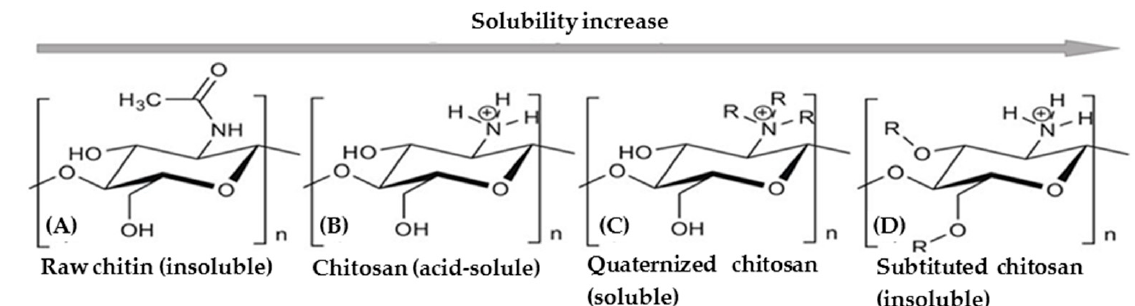
Figure 6. Depiction of chitin and chitosan by functionalization of the chemical structure and the solubility of the biopolymer. ( A ) Raw chitin (insoluble), ( B ) acid soluble chitosan, ( C ) quaternized chitosan (soluble), and ( D ) substituted chitosan show much better solubility under alkaline conditions than chitosan [43].